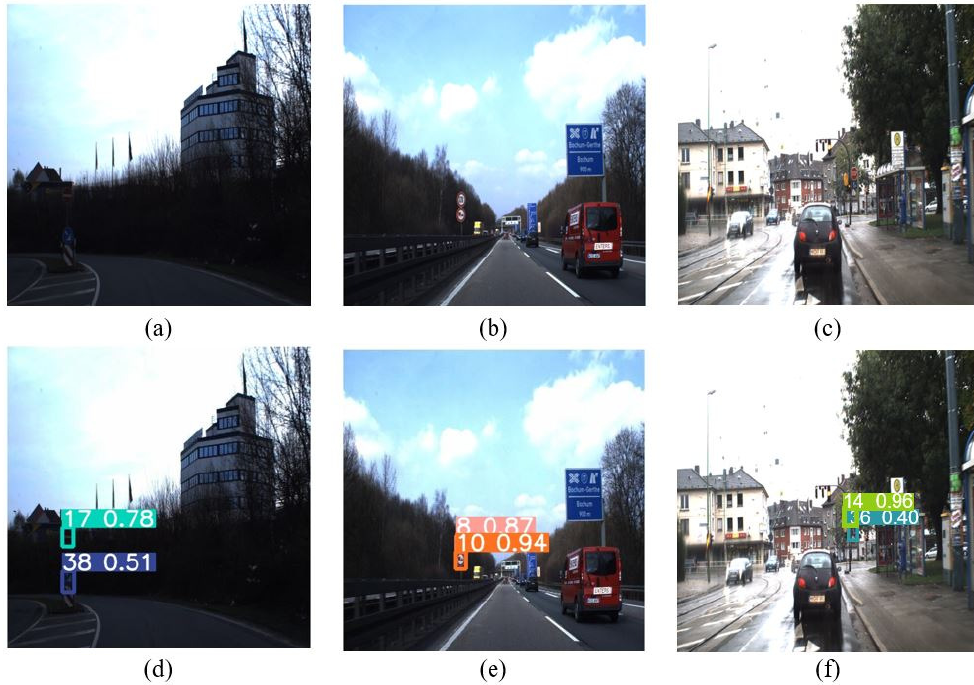
Figure 7. Traffic sign detection results using the FSADD—part 1: ( a ) ground truth—17 and 38, ( b ) ground truth—8 and 10, ( c ) ground truth—14 and 36, ( d ) detection results of ( a ), ( e ) detection results of ( b ), and ( f ) detection results of ( c ).